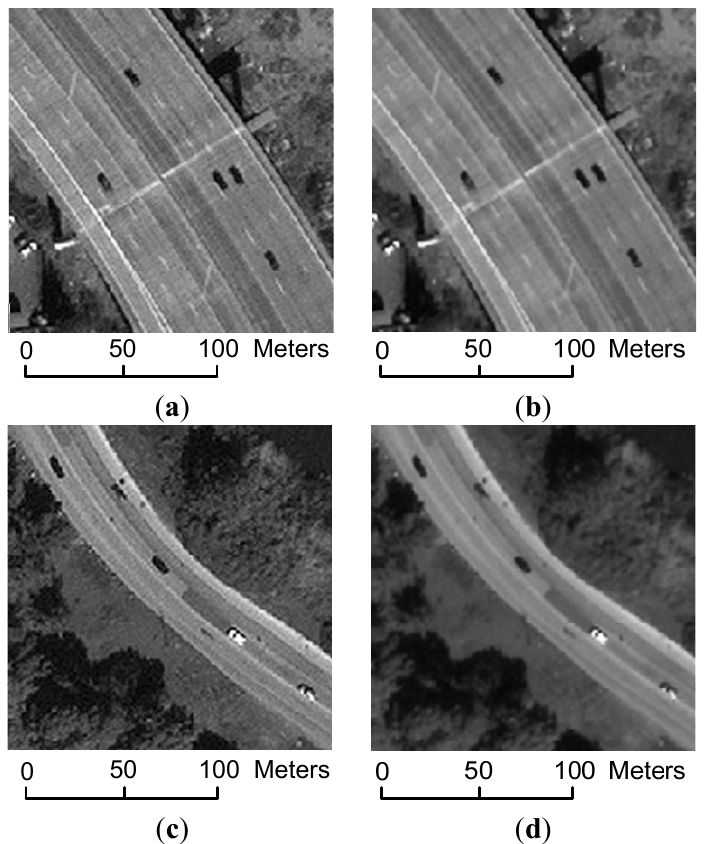
Figure 4. Result of PAN image enhancement: ( a ) regional portion of